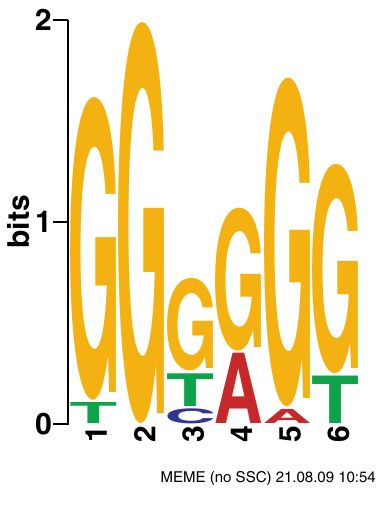
Figure 2. The ideal 6-mer identified in hotspots. Here we show the ideal 6-mer, identified as a composite of the top 100 overrepre- sented motifs in LD-identified hotspots. motifs adequately explains the data. Many motifs are over- represented in the local analysis of recombination events. Many motifs are good fits for global patterns of female recombination.